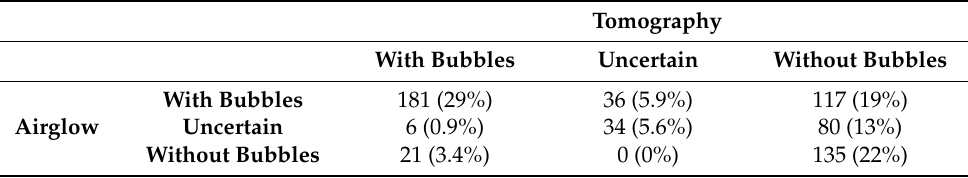
Table 1. Confusion matrix showing the number and percentage of plasma bubbles detected by the tomographic reconstruction and optical instruments in the observatory of Boa Vista.